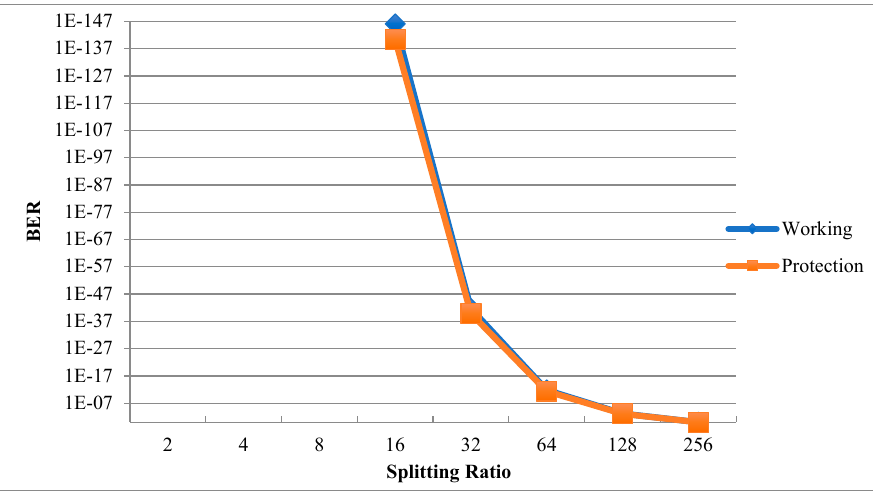
Figure 21. BER result by varying the split ratio.